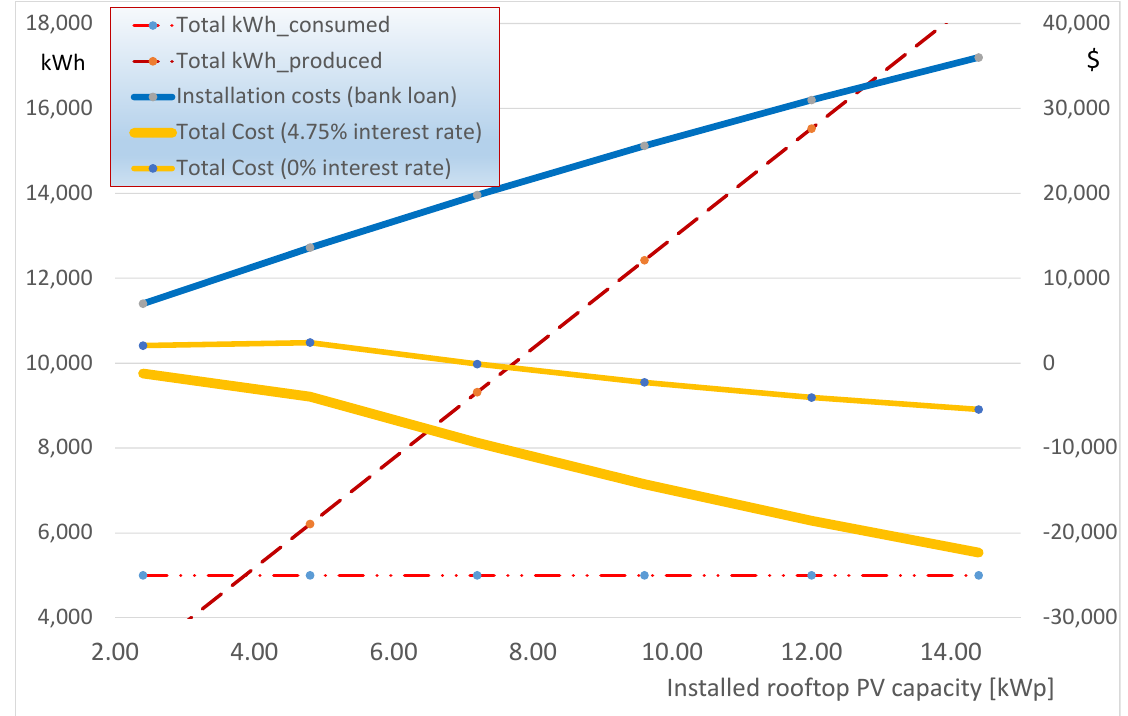
Figure 15. Lifetime performance (20 years) of the system with variable capacity of rooftop PV panels. Electricity price USD 0.10 per kWh, plus a USD 0.10 premium for the part self-consumed. Financing by a bank loan with 4.75% fixed interest rate. For comparison, financing with 0% fixed interest rate is shown.